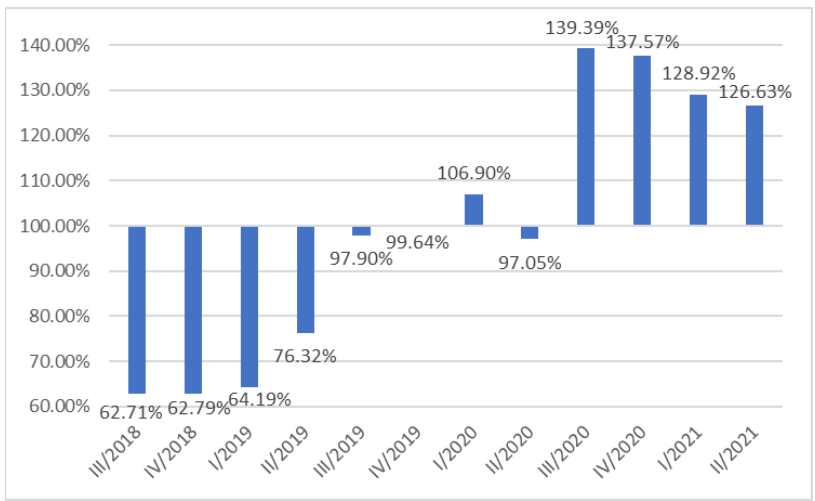
Figure 4. Seasonality of flu vaccination among Polish